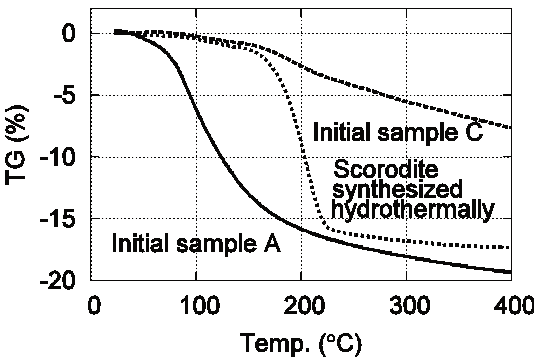
Figure 5. The results of thermo-gravimetry analysis for the initial samples A and C. The result of the hydrothermally synthesized scorodite at 160°C is shown as a reference.